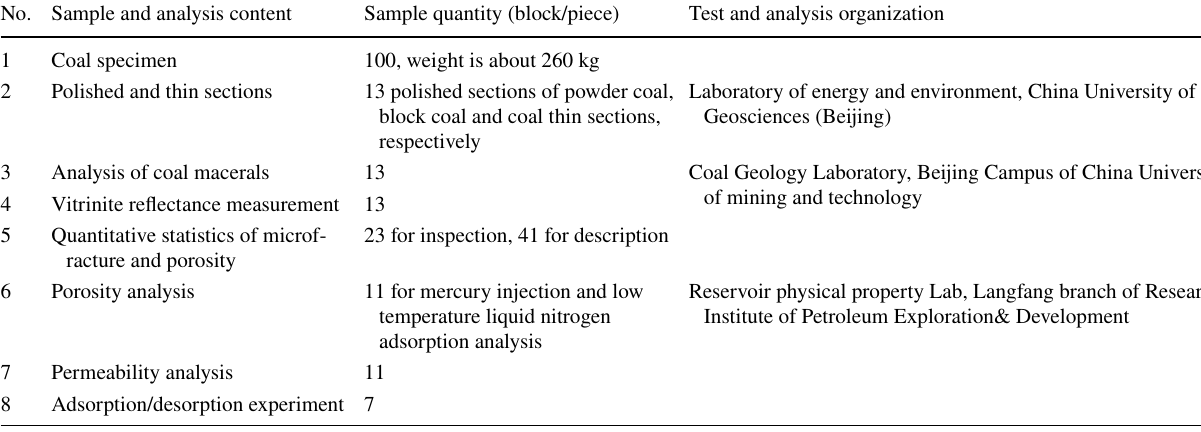
Table 1 Sampling statistics of low-rank coal reservoir in Junggar Basin, NW China